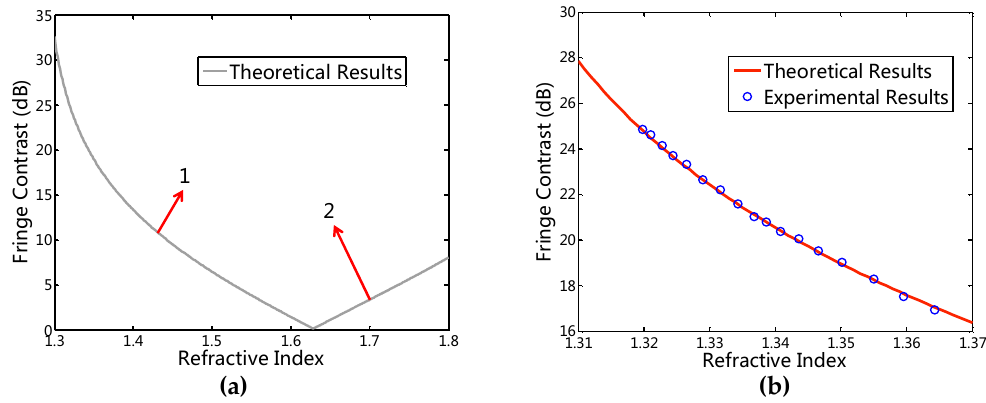
Figure 7. ( a ) Theoretical variation of the fringe contrast versus RI; ( b ) Measured fringe contrast versus the RI, showing the experiment results agree well with the theoretical results.